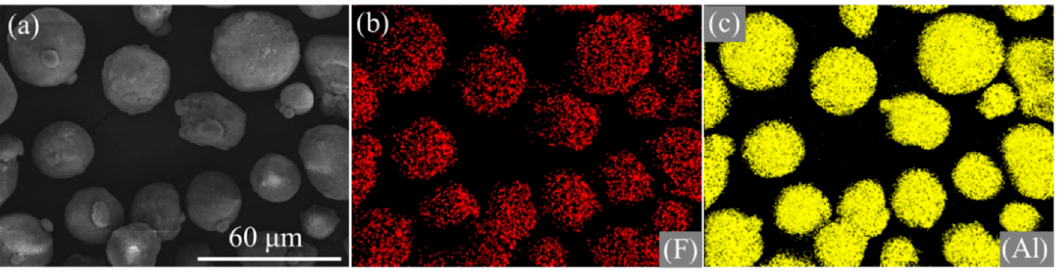
Figure 4. SEM images and elemental maps of Al / PTFE core-shell materials. ( a ) SEM image, ( b ) F, ( c ) Al. The preparation conditions of Al/PTFE were T h = 335 °C, t h = 4 h.